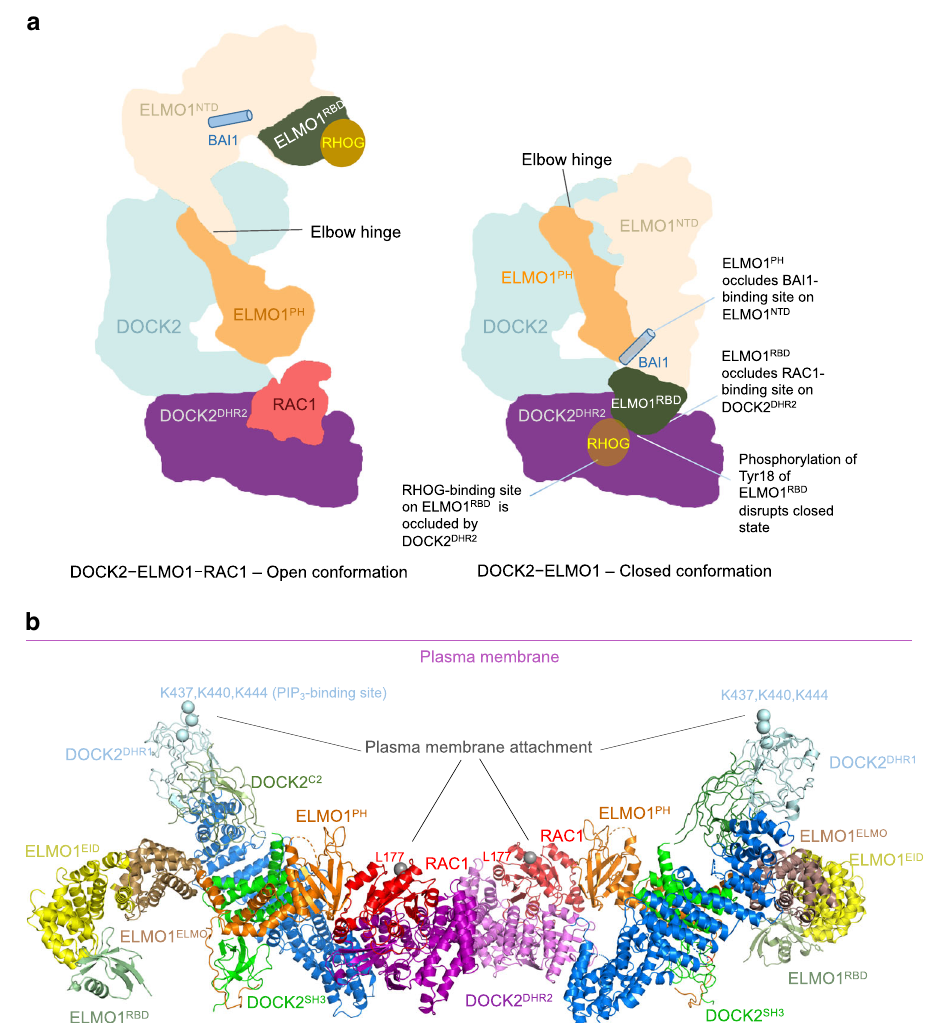
Fig. 9 Schematic of conformational changes of DOCK2 – ELMO1 and membrane attachment model. a In the DOCK2 – ELMO1 – RAC1 ternary complex, ELMO1 NTD adopts the open conformation with binding sites for RAC1, RHOG and BAI1 exposed on DOCK2 DHR2 , ELMO1 RBD and ELMO1 EID (on ELMO1 NTD ), respectively. In the closed, auto-inhibited state of the DOCK2 – ELMO1 binary complex (the dominate state for DOCK2 – ELMO1), rotation of ELMO1 NTD by 120° about an elbow hinge connecting ELMO1 NTD with ELMO1 PH causes ELMO1 NTD to form contacts with DOCK2 DHR2 and ELMO1 PH . These new interfaces create an auto-inhibited state that occludes binding sites for RAC1, RHOG and BAI. Phosphorylation of ELMO1 on either the phosphorylation linker (Fig. 1c) or Tyr 18 of ELMO1 RBD (Fig. 4d) would disrupt the closed state. The view is similar to Figs. 3a, b and 6d. b Membrane attachment sites for DOCK2 and RAC1 are situated on the same face of the DOCK2 − ELMO1 − RAC1 complex. PIP 3 binds to a site de fi ned by the L1 loop of DOCK2 DHR1 incorporating Lys437, Lys440 and Lys444, whereas RAC1 attaches to the membrane through a prenyl group attached to Cys189. Leu177 denotes the last ordered residue of the RAC1 crystal